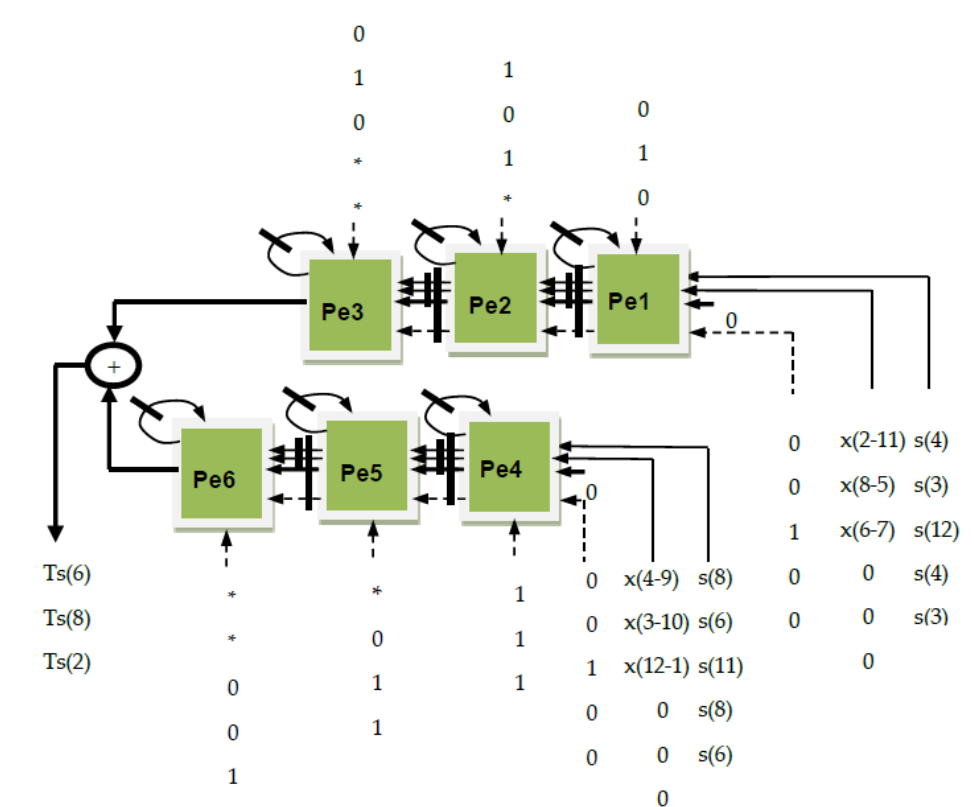
Electronics 2021 , 10 , x FOR PEER REVIEW Figure 7. The VLSI architecture of the hardware core that implements Equation (30), where * marks a delay of one clock cycle. In Figure 8 we have mapped the data flow graph for Equation (31) and we have ob- tained the systolic array from below. We can see that the architecture presented computes the auxiliary output sequences Ts(4), Ts(10) and Ts(12), using the auxiliary input se- quences x(4 − 9), x(3 − 10), x(12 − 1) and x(2 − 11), x(8 − 5), x(6 − 7) of the DST-IV transform.